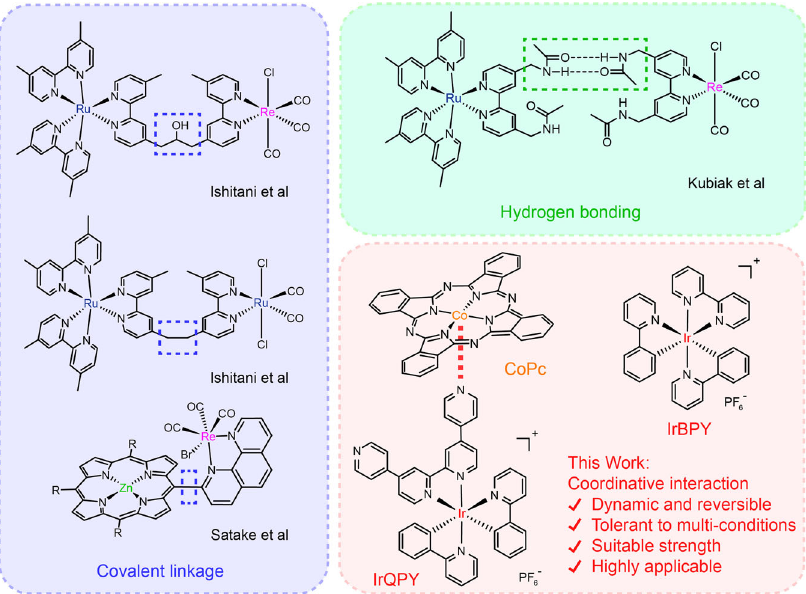
Fig. 1 Comparison of different methods to bridge PS and catalyst for CO 2 reduction. The blue region displays the examples of covalent linkages between PS and catalyst from Ishitani et al. 20,22 and Satake et al. 24 . The green region displays the example of hydrogen bonding between PS and catalyst from Kubiak et al. 35 . The red region introduces the coordinative interaction applied in this work, showing the used molecules and the merits of coordinative interaction.